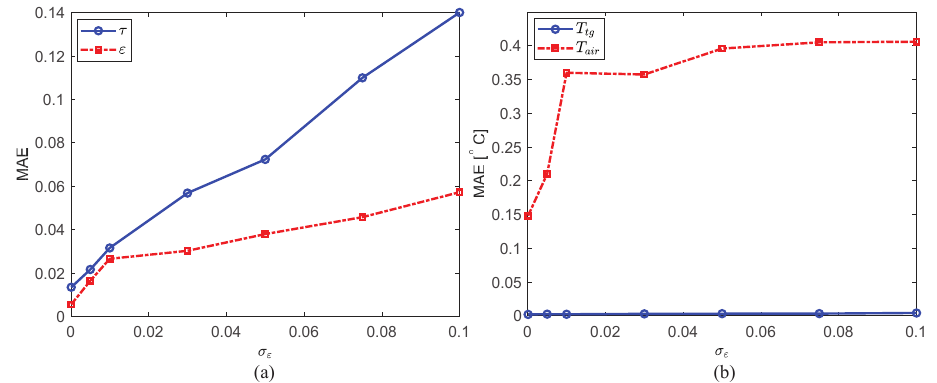
Figure 21. Parameter separation performance based on emissivity noise ( σ ε ): ( a ) MAE of τ , ε , and ( b ) MAE of T tg , T air .